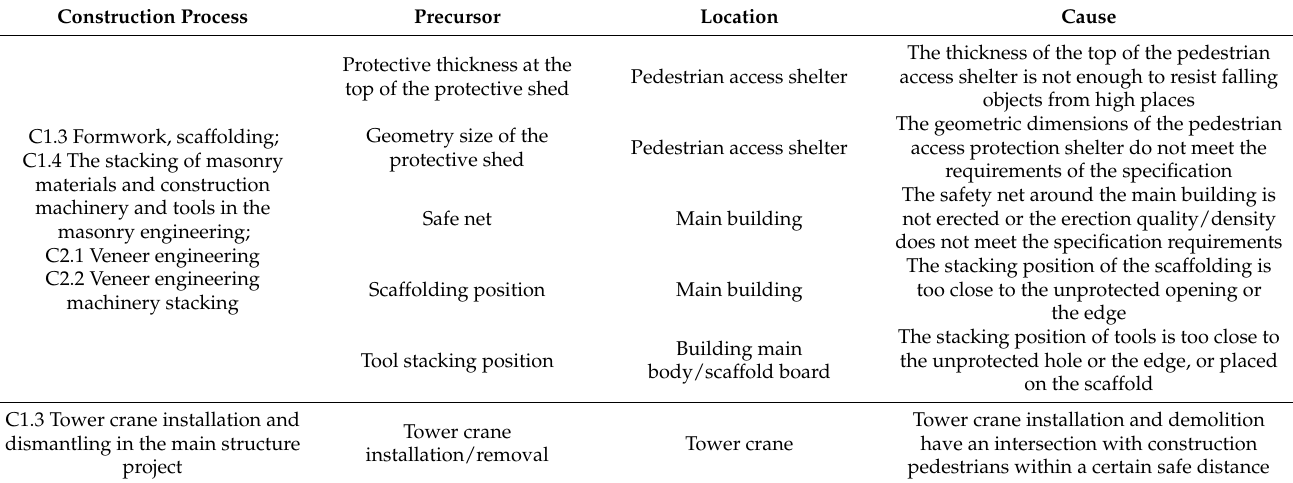
Table 2. Example of precursor